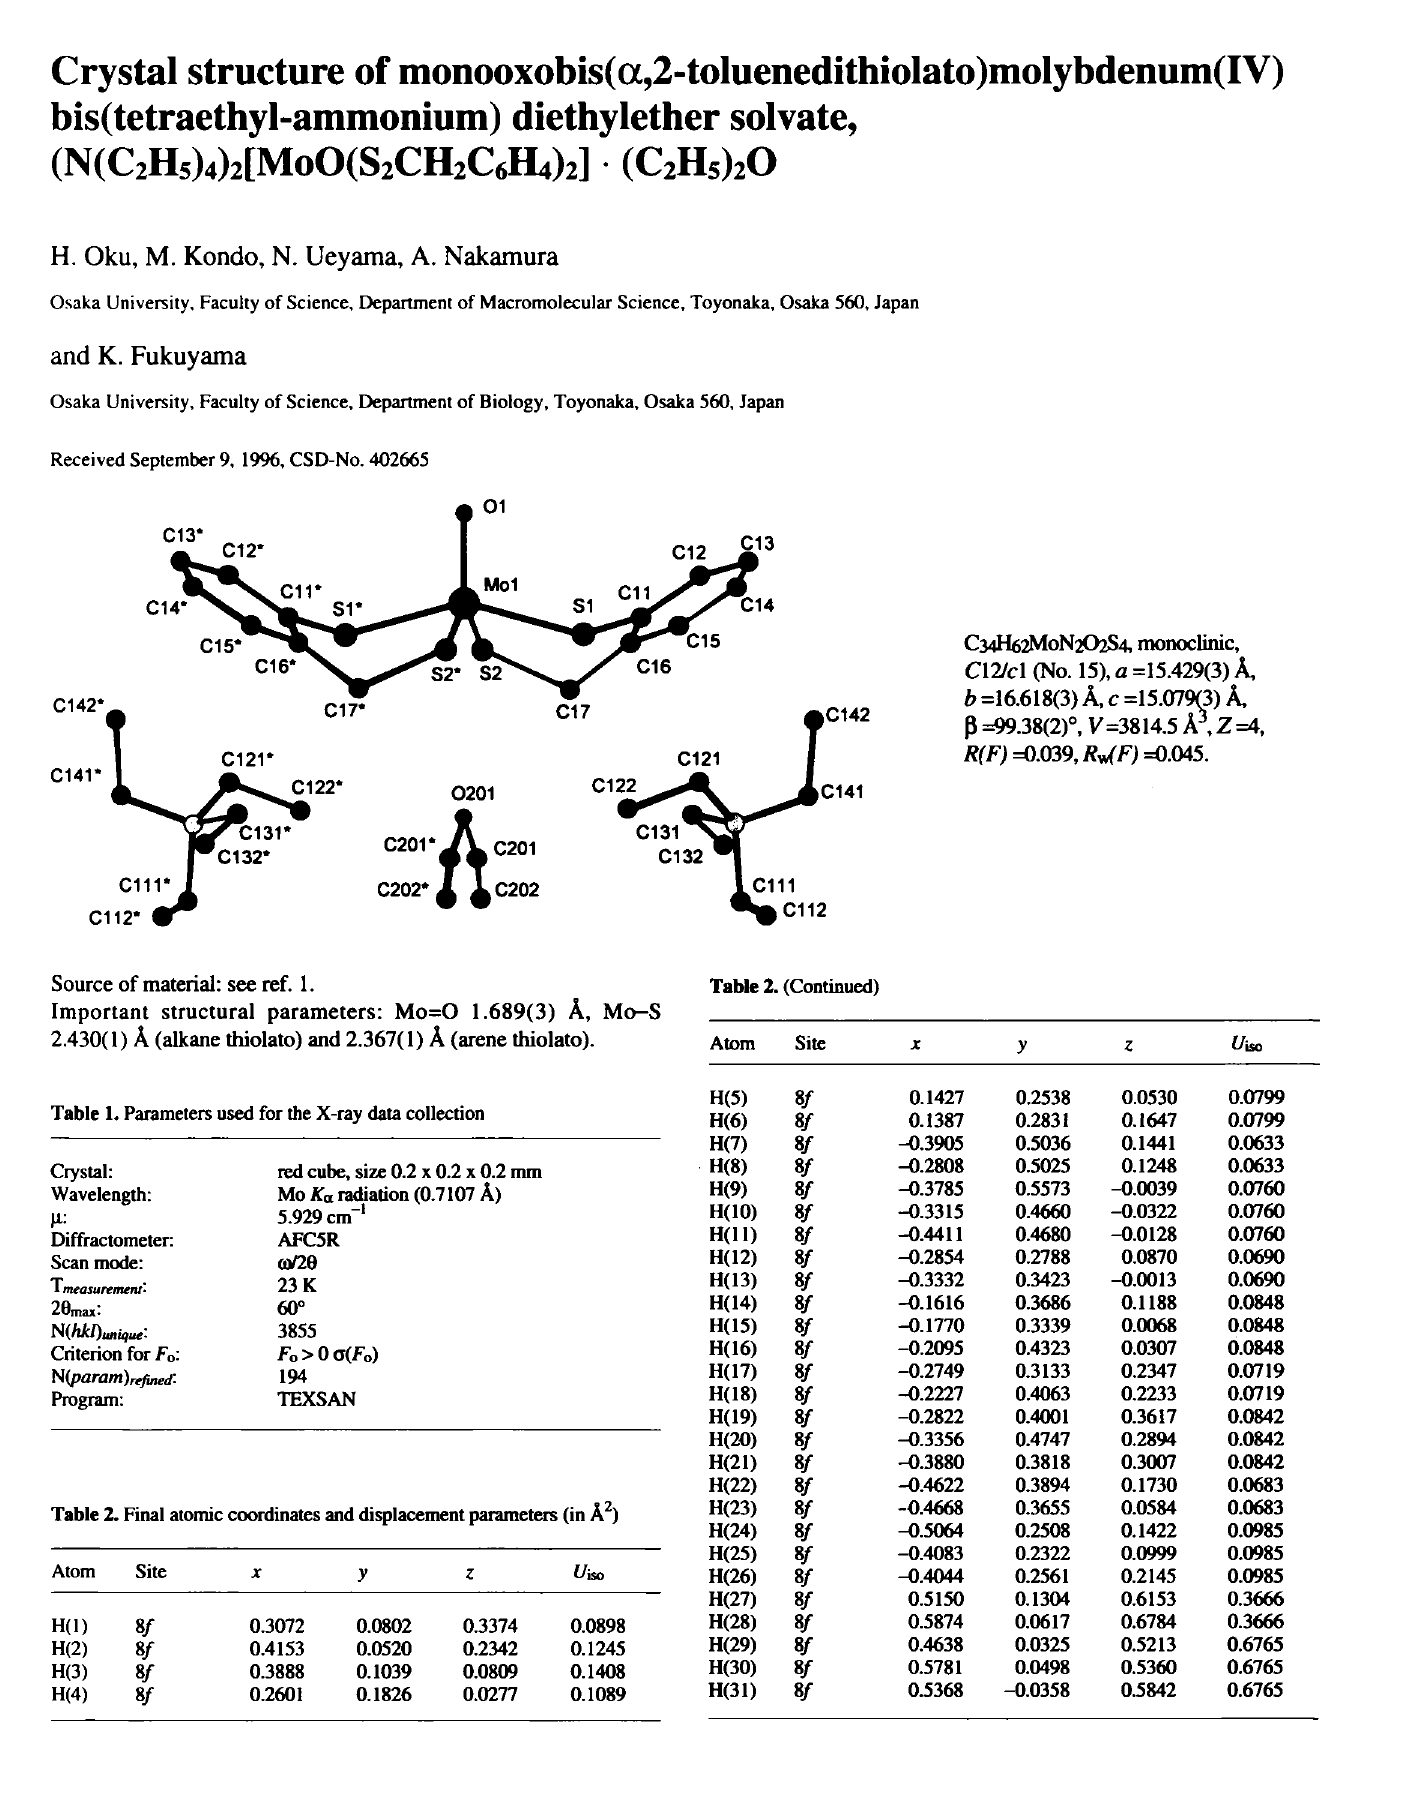
Table 2. Final atomic coordinates and displacement parameters (in Â 2